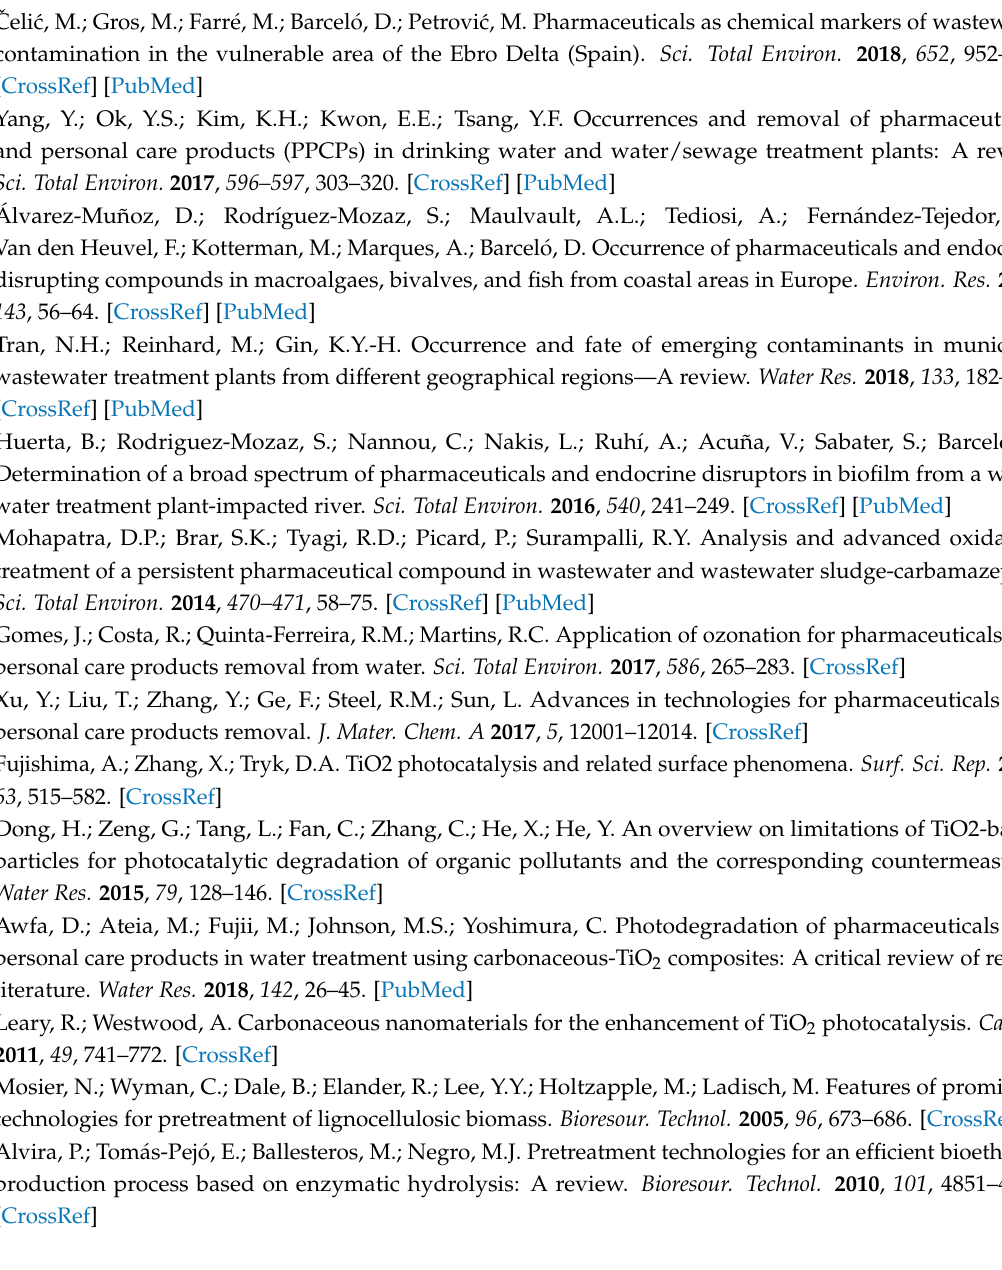
Figure S2: Evolution of ACE concentration with and without irradiation using TiO 2 /Fe-C as photocatalyst ([Photocatalyst] 0 : 250 mg · L − 1 of TiO 2 ; [ACE] 0 after adsorption equilibrium: 5 mg · L − 1 ; intensity of irradiation: 600 W · m − 2 ); Figure S1: Settling test for TiO 2 /Fe-C (left) and TiO 2 (right)